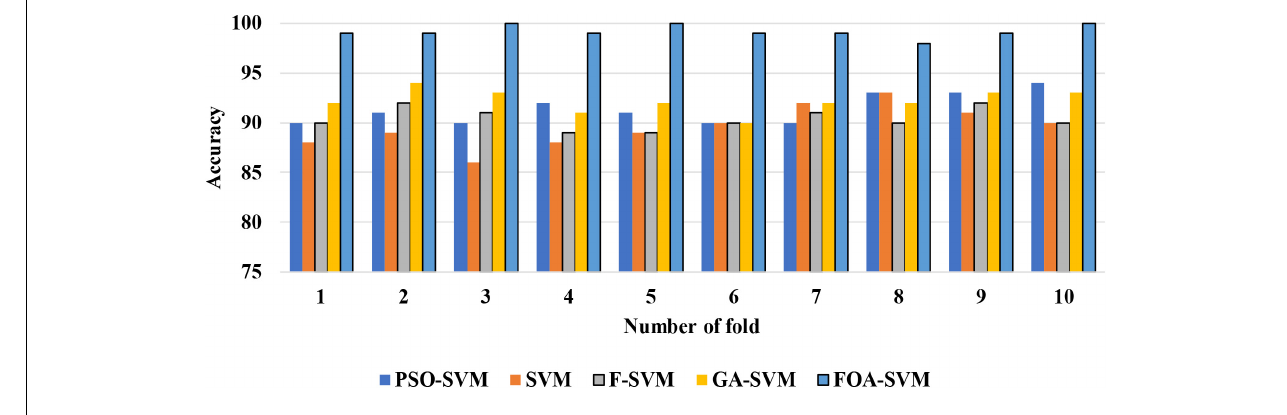
FIGURE 4 | The detailed classification accuracy of 10 folds.